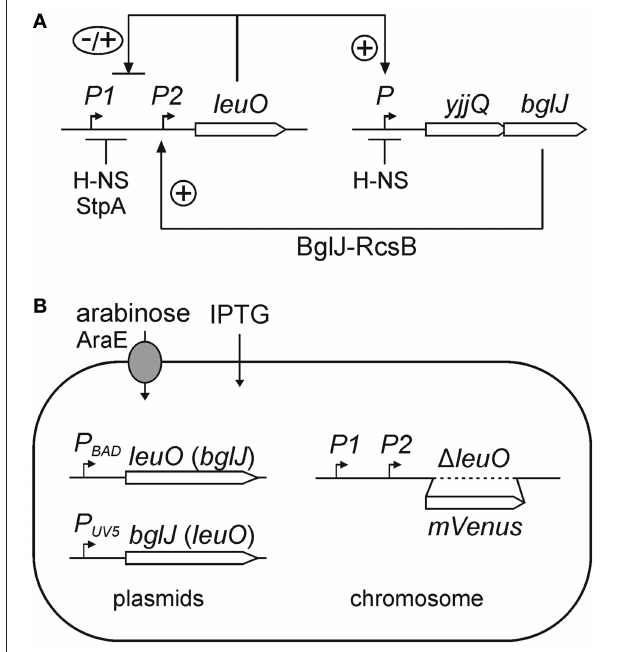
FIGURE 1 | (A) Regulation of leuO by interlocked double-positive and negative feedback loops. Transcription of leuO is repressed by H-NS and StpA, and is activated by the BglJ-RcsB heterodimer. LeuO activates transcription of the yjjQ-bglJ operon that is also repressed by H-NS. Mutual positive regulation represents a double-positive feedback loop. In addition, LeuO inhibits activation of the leuO promoter P2 by BglJ-RcsB resembling a negative feedback. (B) Experimental system for analyzing regulation of leuO transcription by BglJ-RcsB and LeuO. To monitor leuO transcription a PleuO mVenus fusion was constructed by replacement of the native leuO gene with mVenus . The chromosomal copy of bglJ was deleted (allele 1 [ yjjP-yjjQ-bglJ ]) to avoid feedback regulation via LeuO. BglJ and LeuO were provided by two sets of compatible plasmids that are pKES303 ( P BAD leuO , p15A- ori ) and pKETS26 ( P UV 5 bglJ , pSC- ori ) or plasmid pKES302 ( P BAD bglJ ) and pKETS25 ( P UV 5 leuO ). Expression of bglJ and leuO , respectively, was induced with gradually increasing concentrations of the inducers arabinose and IPTG, respectively. To avoid feedback regulation by arabinose the strain background is 1 ( araC araBAD ) 1 araH-F , P cp 8 araE resulting in constitutive expression of the arabinose transporter AraE. In addition, the lac genes were deleted,